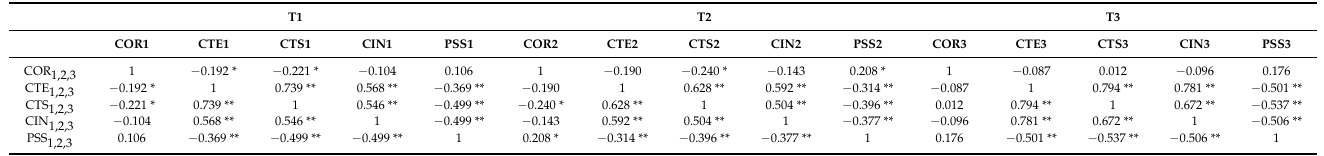
Table 3. Relationships between research